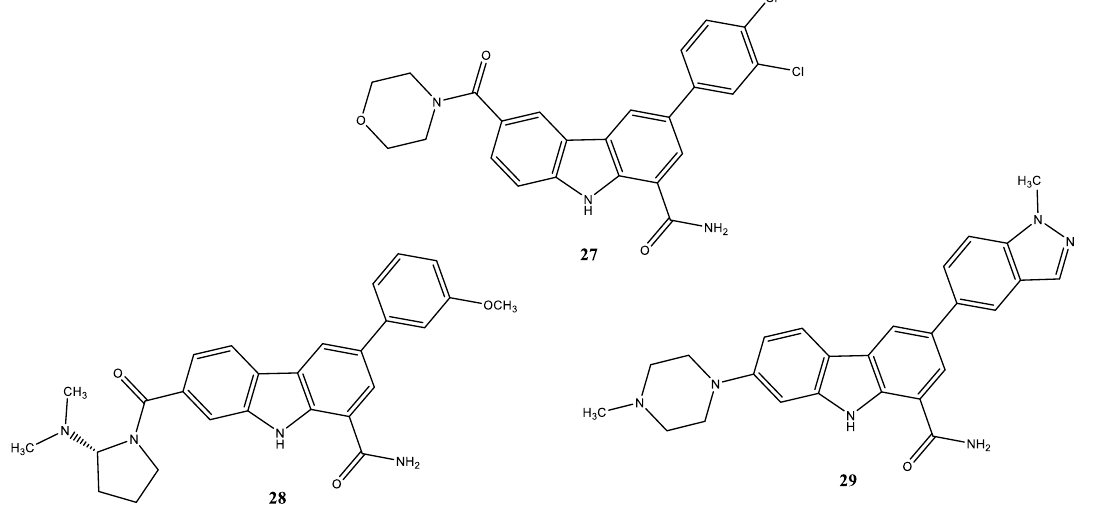
Figure 13. Structure of 9 H -carbazole-1-carboxamides ( 27-29